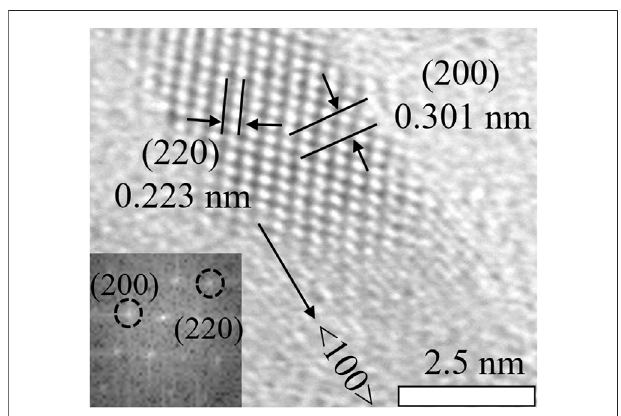
FIGURE 3 | High resolution TEM image of the crystal lattice and the corresponding FFT